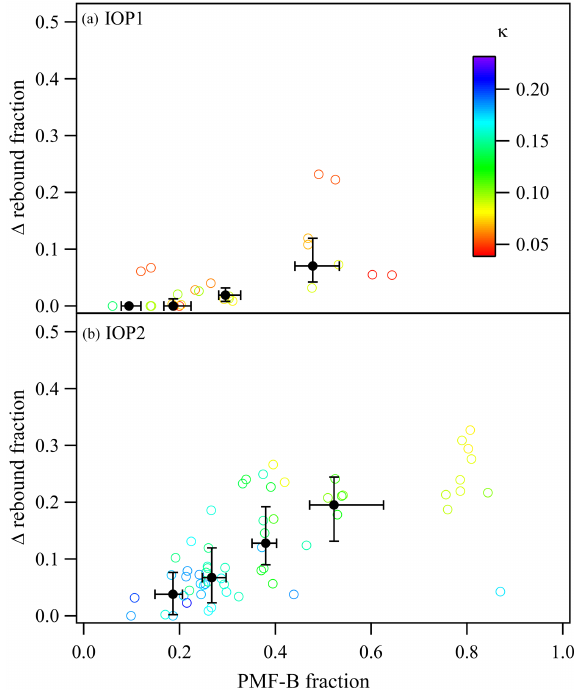
Figure 9. Scatter plot of rebound deviation with the fractional load- ing of PMF group B for (a) IOP1 and (b) IOP2. The data points are colored according to the corresponding hygroscopicity parameter κ . For clarity of presentation, data points are shown for apparatus RH values between 73 and 78%, although the trend applies more broadly. As a guide to the eye, in each panel data are divided into four groups, and medians and quartiles of the groups are plotted as black circles and whiskers, respectively.